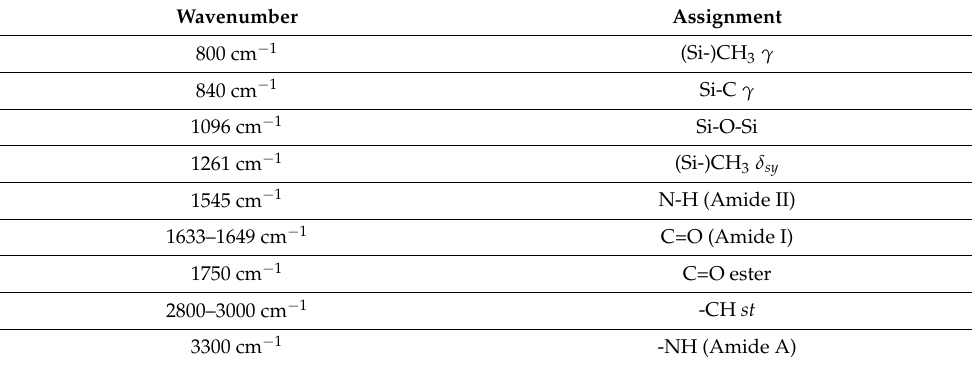
Table 3. Assignments of the main FTIR absorption bands observed for the spectra in Figure 2.